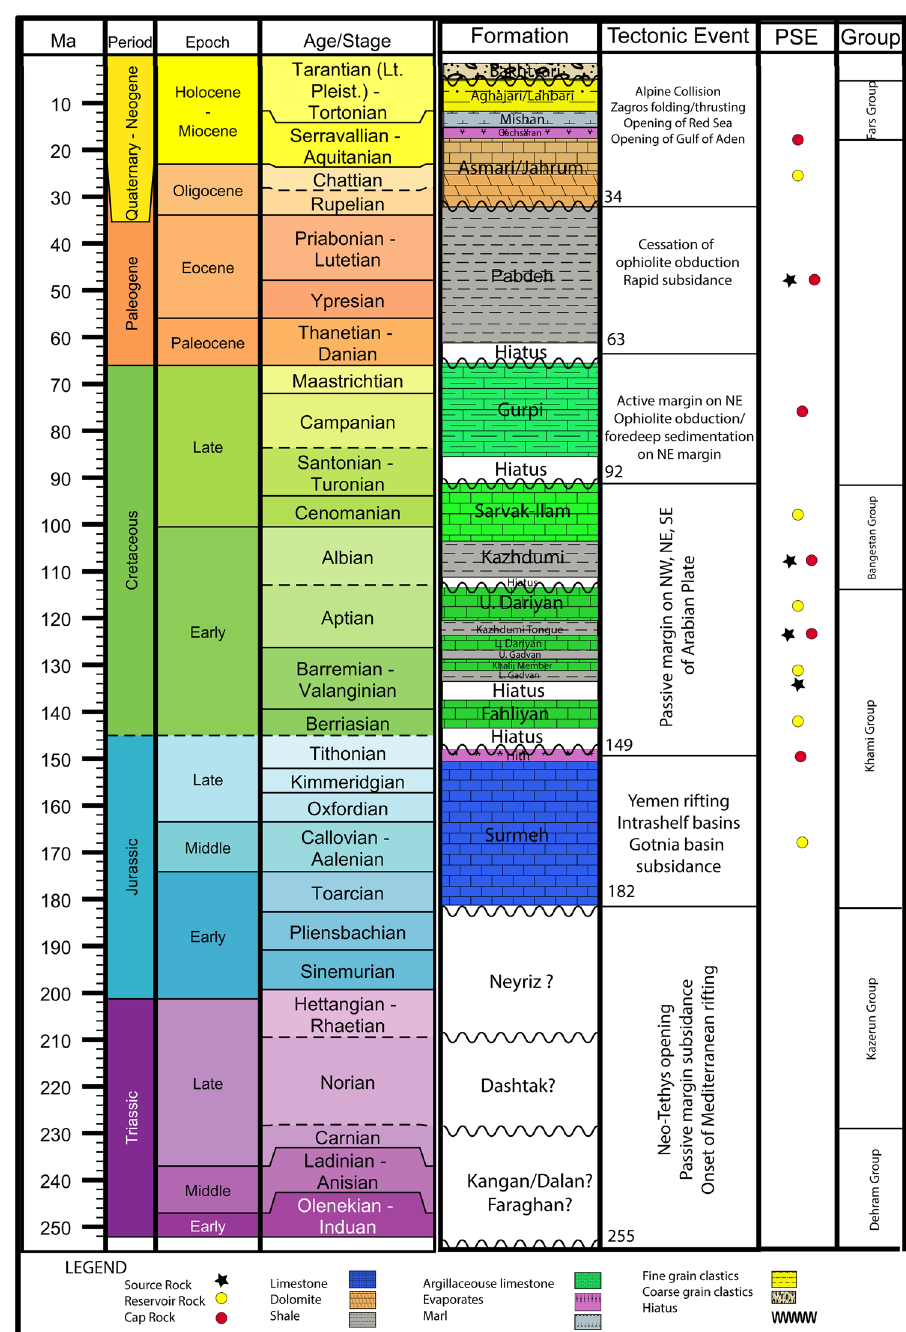
Fig. 2 Simplified chrono- lithostratigraphic chart of the study area (Al-Husseini 2008; Alsharhan 2014; Bordenave 2014; Cohen et al. 2013; James and Wynd 1965; Gradstein et al. 2009; Ziegler